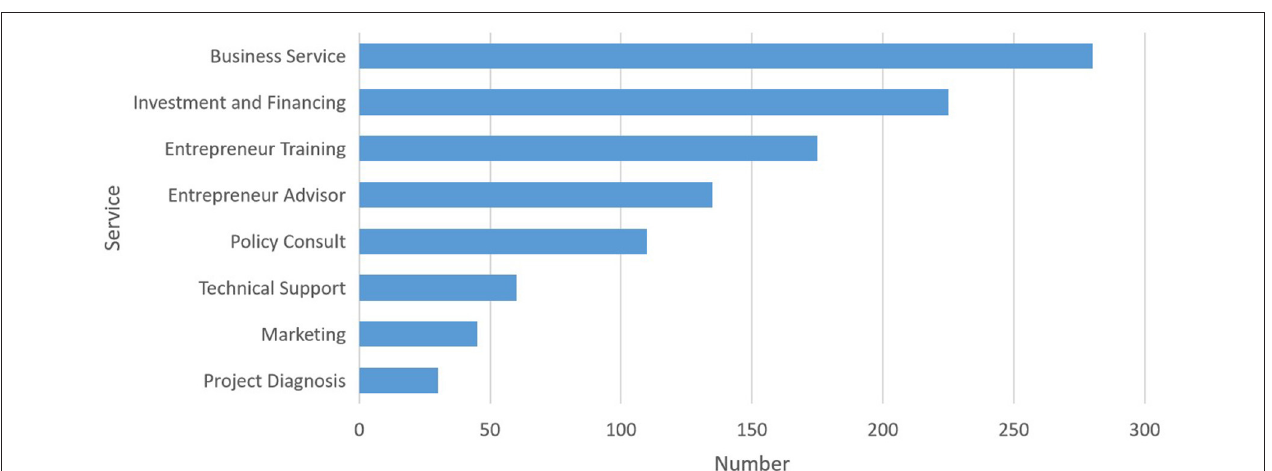
FIGURE 2 | The services provided by